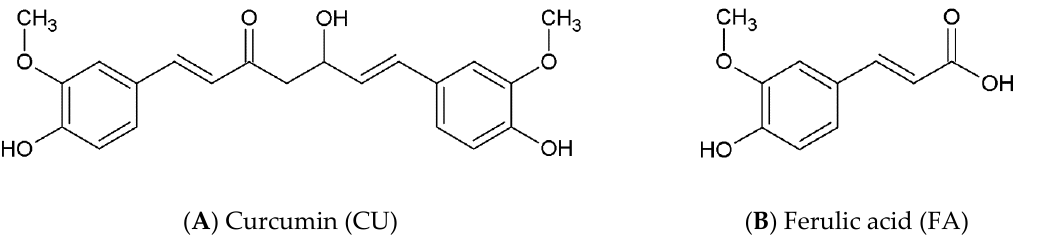
Figure 1. Chemical structures of the amyloid-beta (A β ) inhibitor ( A ) curcumin (CU) and ( B ). non-inhibitor ferulic acid (FA).